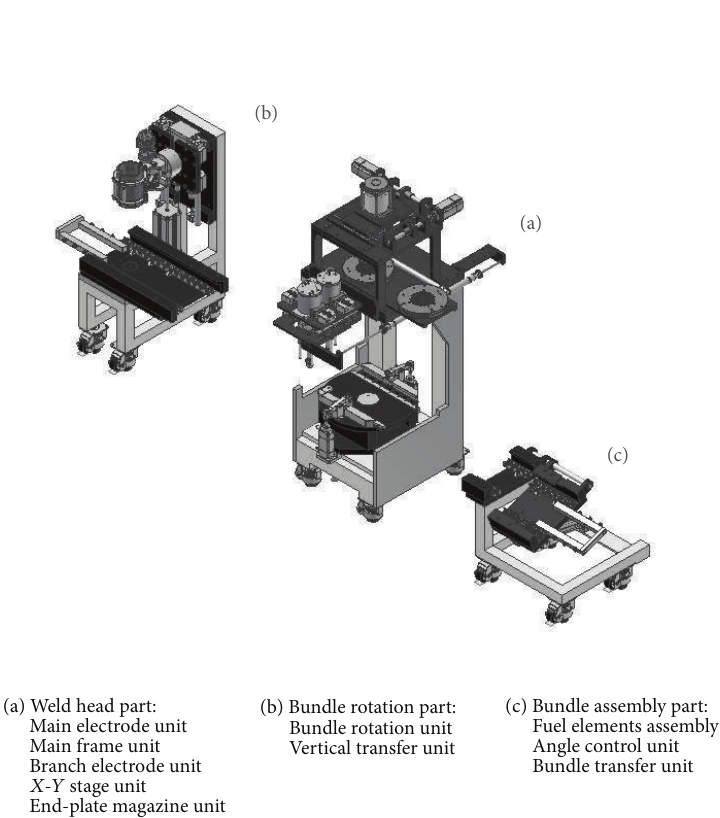
Figure 4: Design construction of remote welding